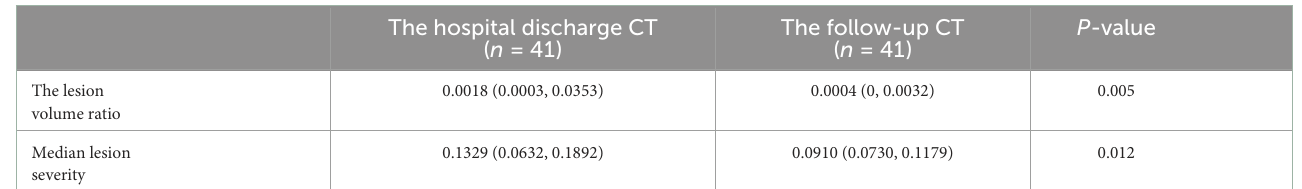
TABLE 2 Changes in lesions under